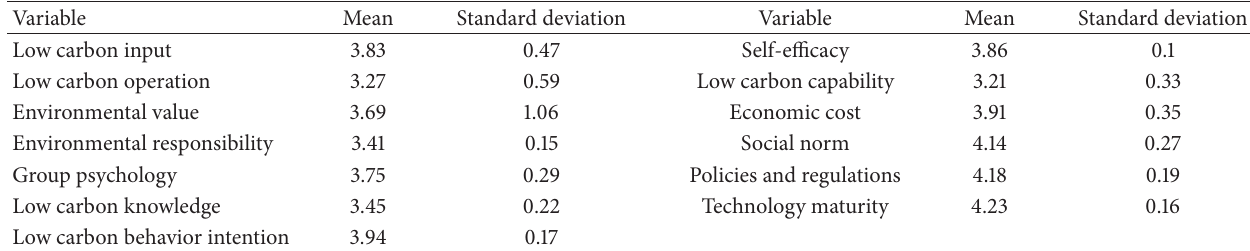
Table 1: The descriptive statistical analysis of variables.